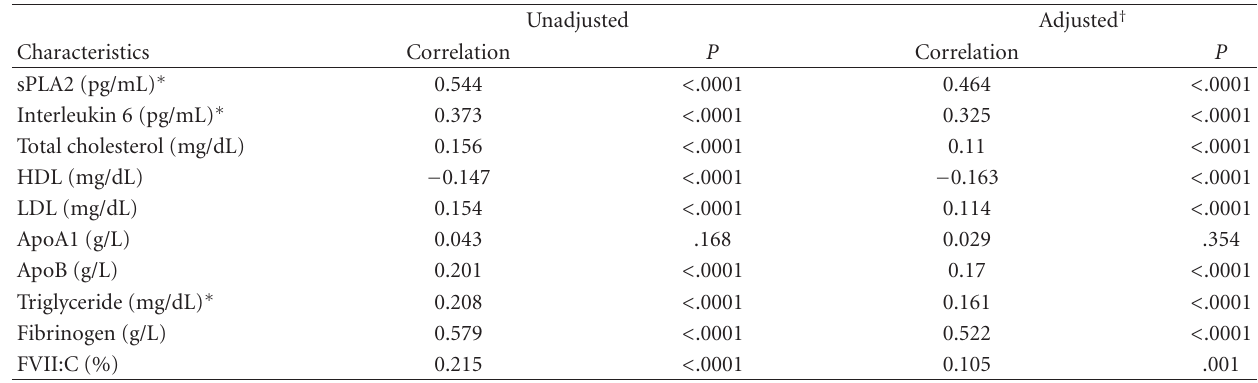
Table 3: Correlation of high-sensitivity C-reactive protein (hsCRP) levels with inflammatory markers and lipids. Unadjusted